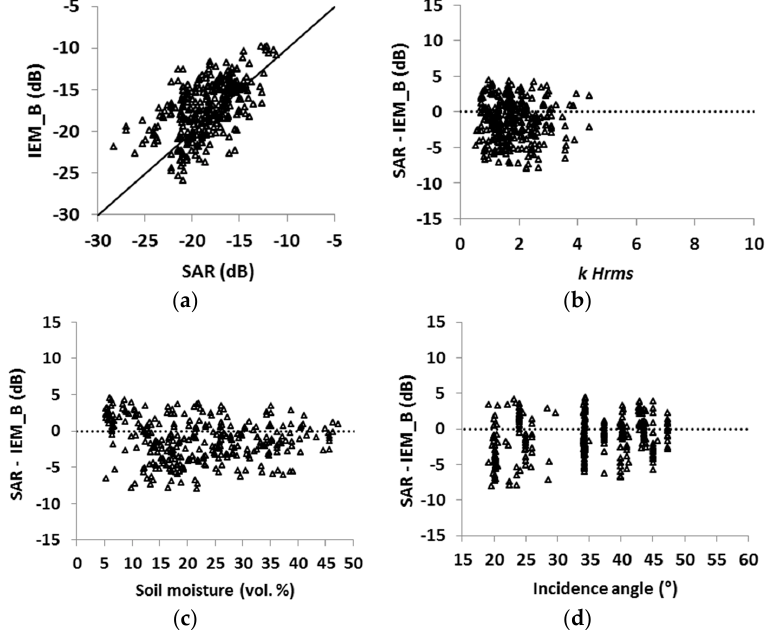
Figure 14. Comparison between backscattering coefficients derived from SAR images and those estimated from IEM_B in C ‐ band at HV polarization using GCF. ( a ) IEM_B simulations vs. SAR data; ( b ) difference between SAR signal and IEM_B vs. soil roughness ( kHrms ); ( c ) difference between SAR signal and IEM_B vs. soil moisture ( mv ); ( d ) difference between SAR signal and IEM_B vs. incidence angle.